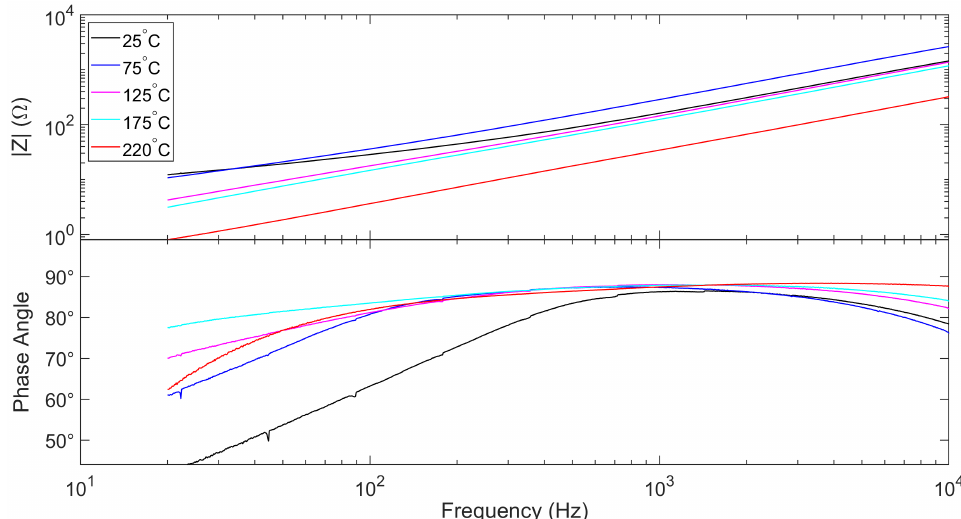
Figure 5. Impedance and its phase of the excitation coil measured under different temperatures. Different color indicates different sensor temperature. The values of | Z | at 1 kHz are 161.4 Ω at 25 ◦ C, 286.74 Ω at 75 ◦ C, 144.3 Ω at 125 ◦ C, 124.5 Ω at 175 ◦ C and 34.3 Ω at 220 ◦